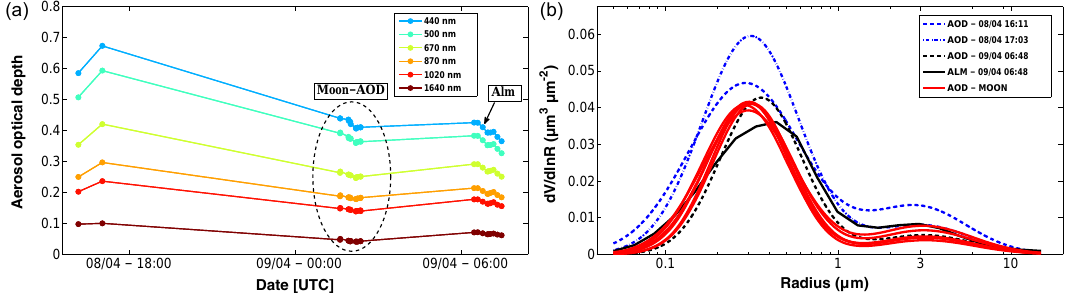
Figure 13. (a) Aerosol optical depth values measured at the Lille site from the evening of 8 April 2015 to the morning of 9 April 2015. Measurements were taken during daylight hours with sun-photometer number #741 and night-time measurements were obtained by moon- photometer number #841. (b) Size distribution retrieved by GRASP-AOD inversion using τ a from the evening of 8 April 2015 (blue lines), the measurements during the night (red lines), and τ a corresponding to the almucantar on the morning of 9 April 2015 (black dashed line). The size distribution from the AERONET standard inversion (06:48) is also represented in the figure as a reference (black solid line).